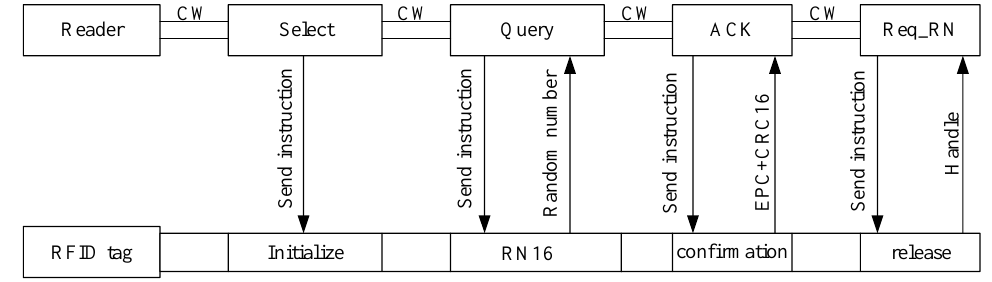
Figure 1. Schematic diagram of radio frequency communication.